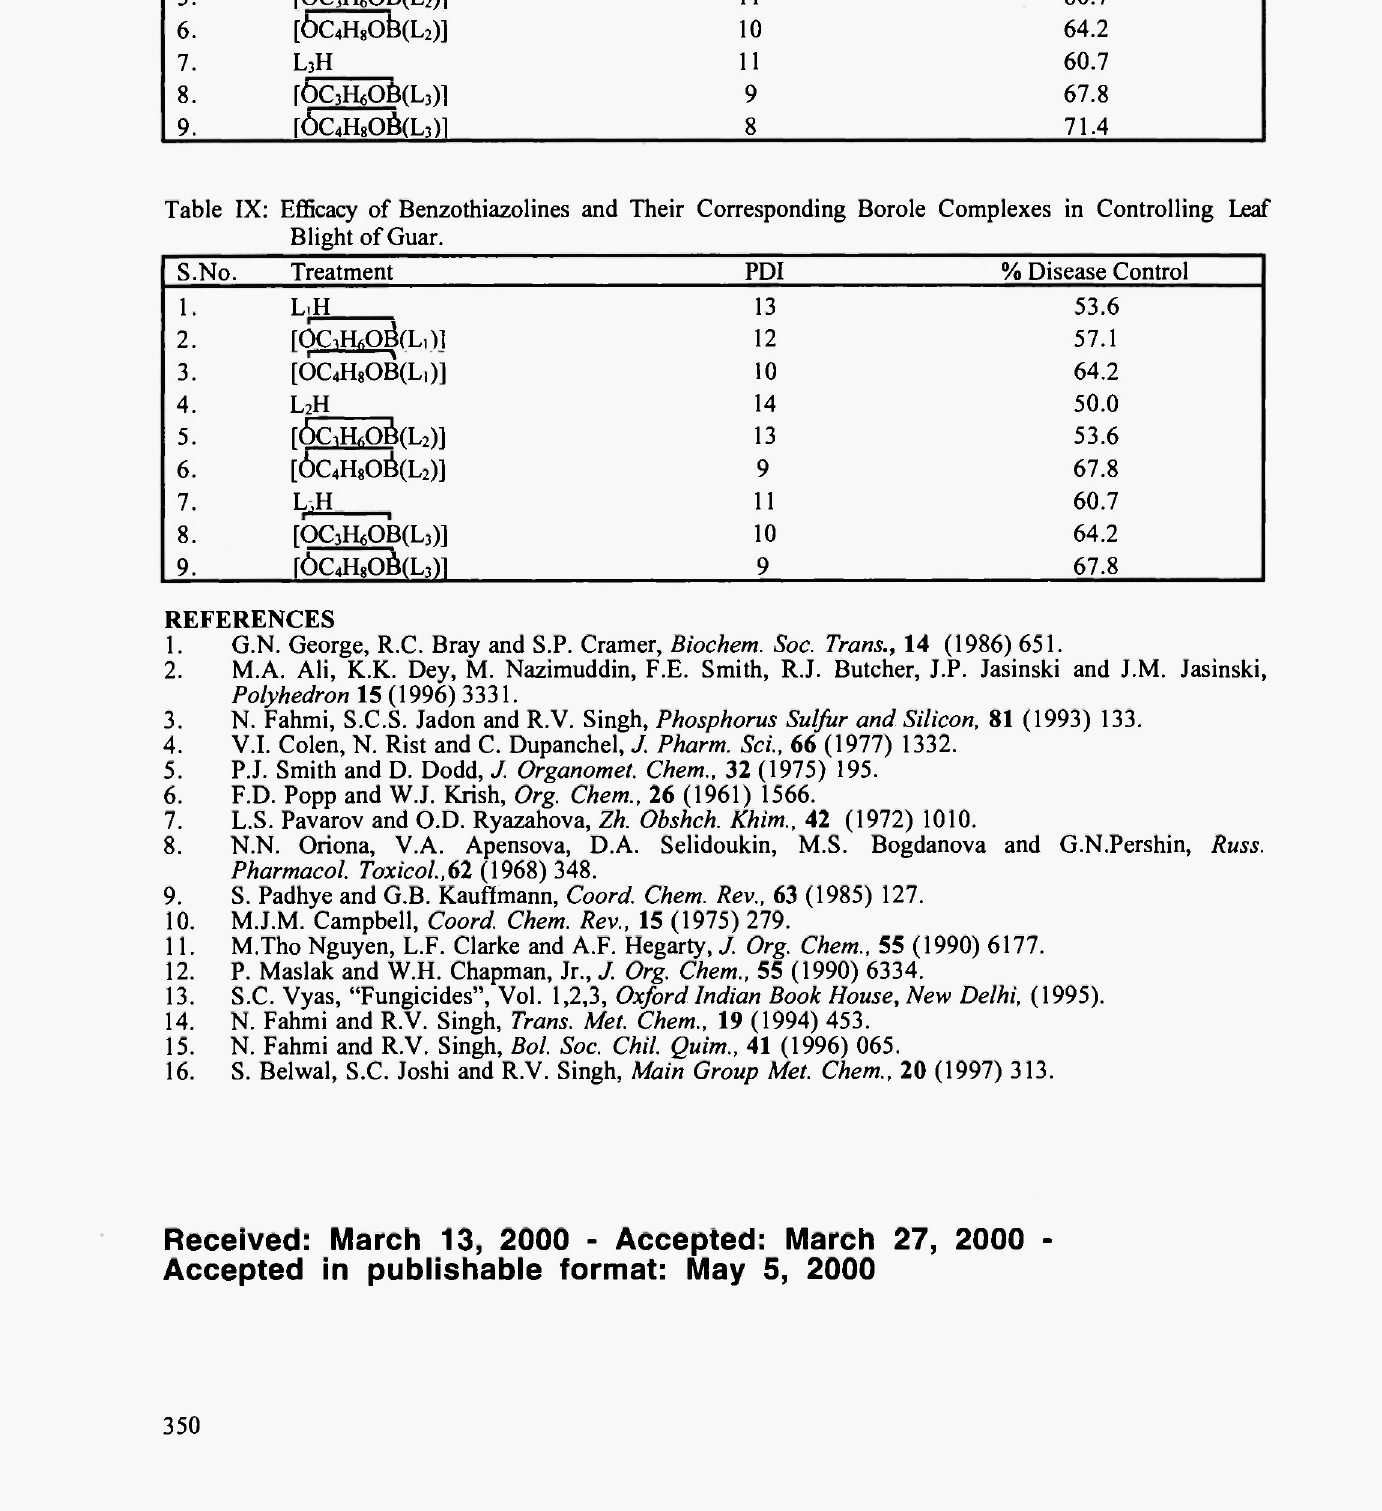
Table IX: Efficacy of Benzothiazolines and Their Corresponding Borole Complexes in Controlling Leaf Blight of